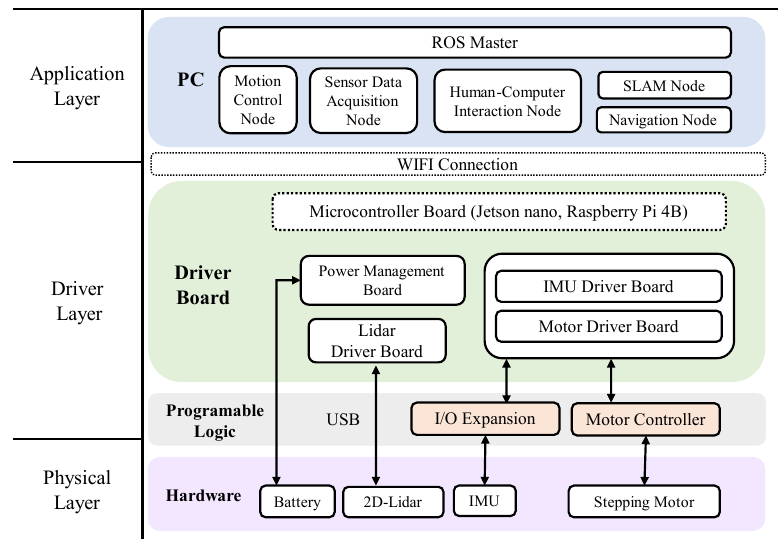
Figure 4. System structure of the Owlbot robotic platform.